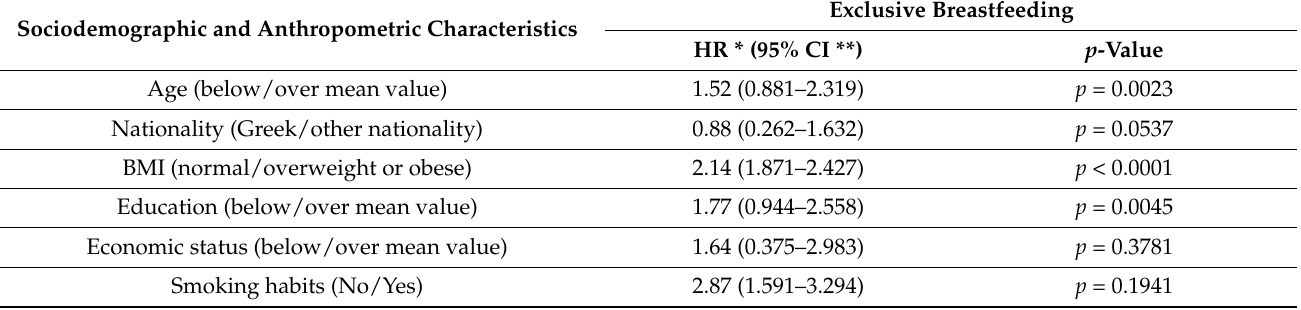
Table 2. Multivariate logistic regression analysis for assessing the influence of exclusive breastfeeding on maternal overweight and obesity after adjustment for potential